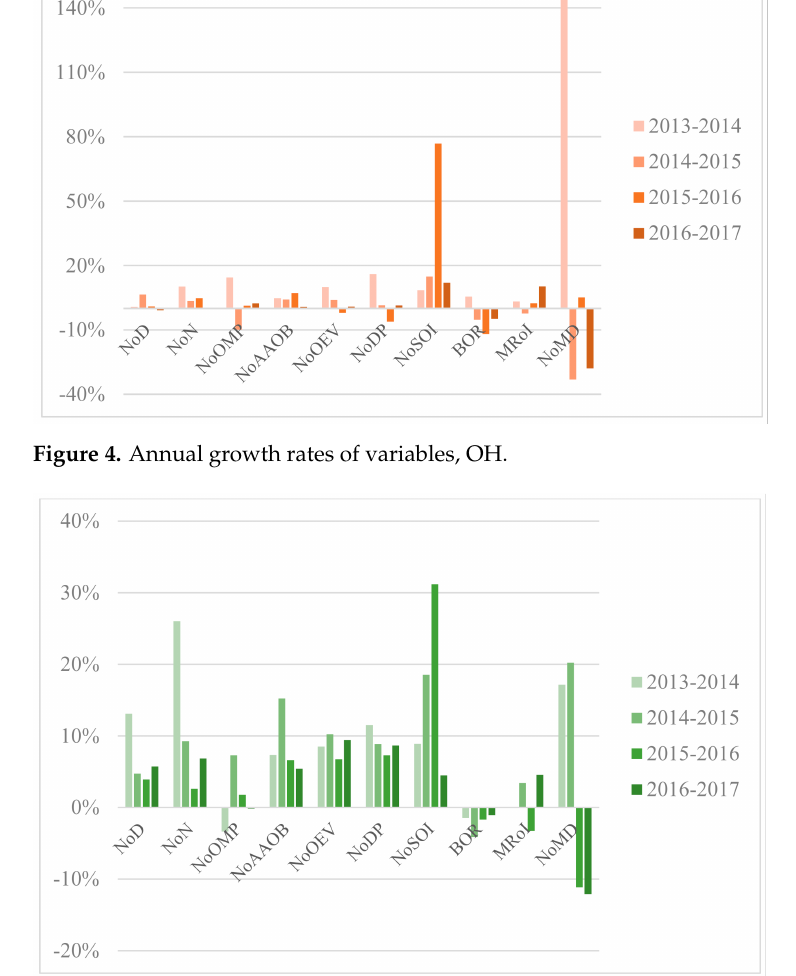
Figure 5. Annual growth rates of variables,